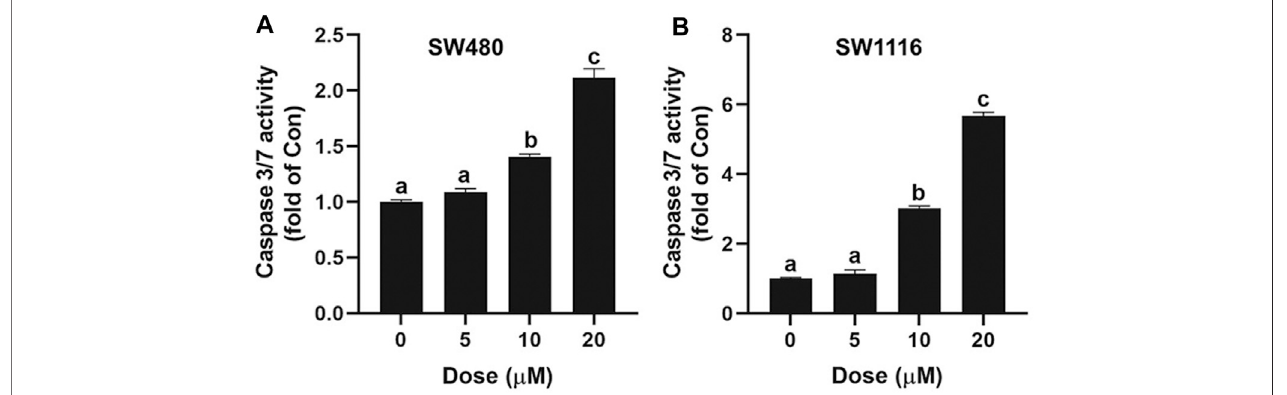
FIGURE 5 | Effect of ivermectin on Caspase 3/7 in SW480 and SW1116 cells. SW480 (A) and SW1116 (B) cells were treated with different concentrations of ivermectin (0, 5, 10, and 20 μ M) for 6 h, and then the Caspase 3/7 activity was measured described in the “ Materials and Methods ” section. Data were analyzed using one-wayANOVAfollowingTukey ’ s t -test.Thedataareshownasthemeans ± SDofthreeindependentexperiments.(a – c):sameletters,nostatisticaldifference;different letters, the statistical difference ( p < 0.05). IVM, ivermectin.